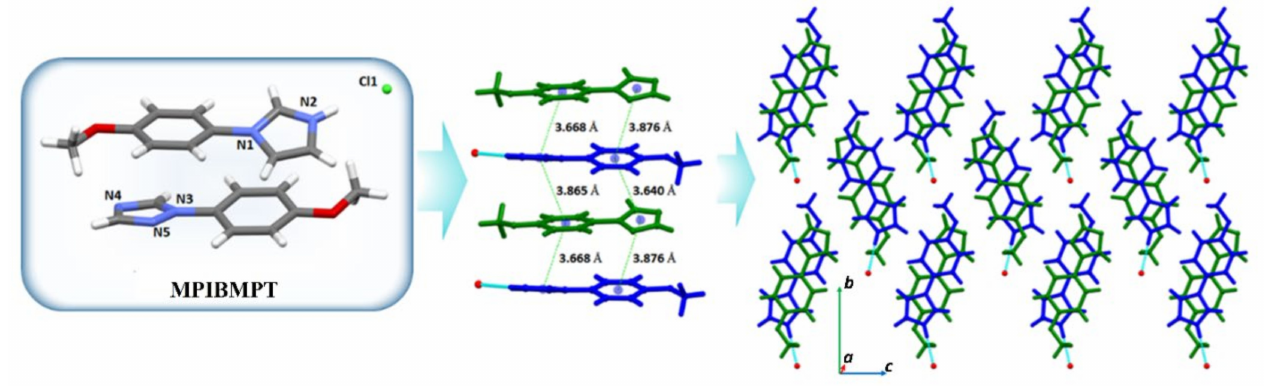
Figure 6. Illustration of the asymmetric unit and crystal packing in